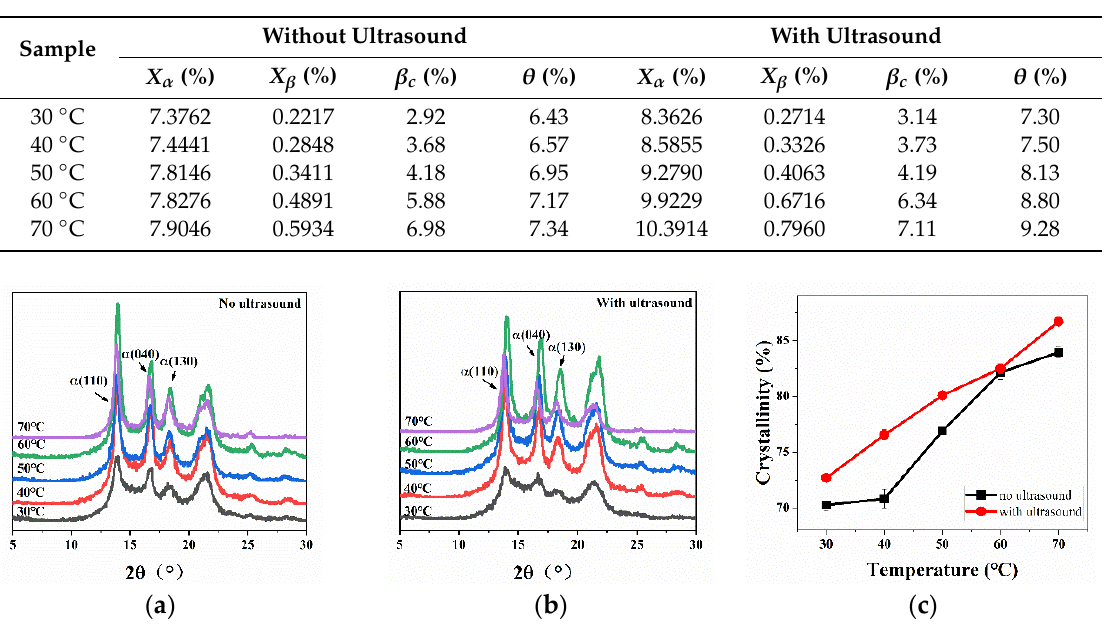
Table 3. The values of β c and θ of WBG-PP with di ff erent cooling temperatures without ultrasound and with ultrasound.